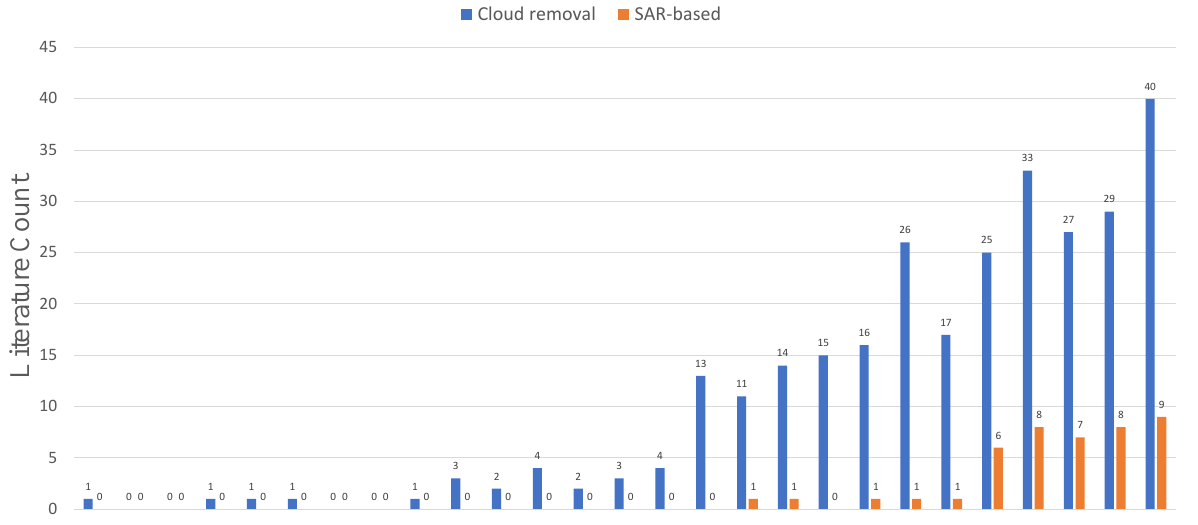
Figure 1. Yearly literature counts of journal papers introducing cloud